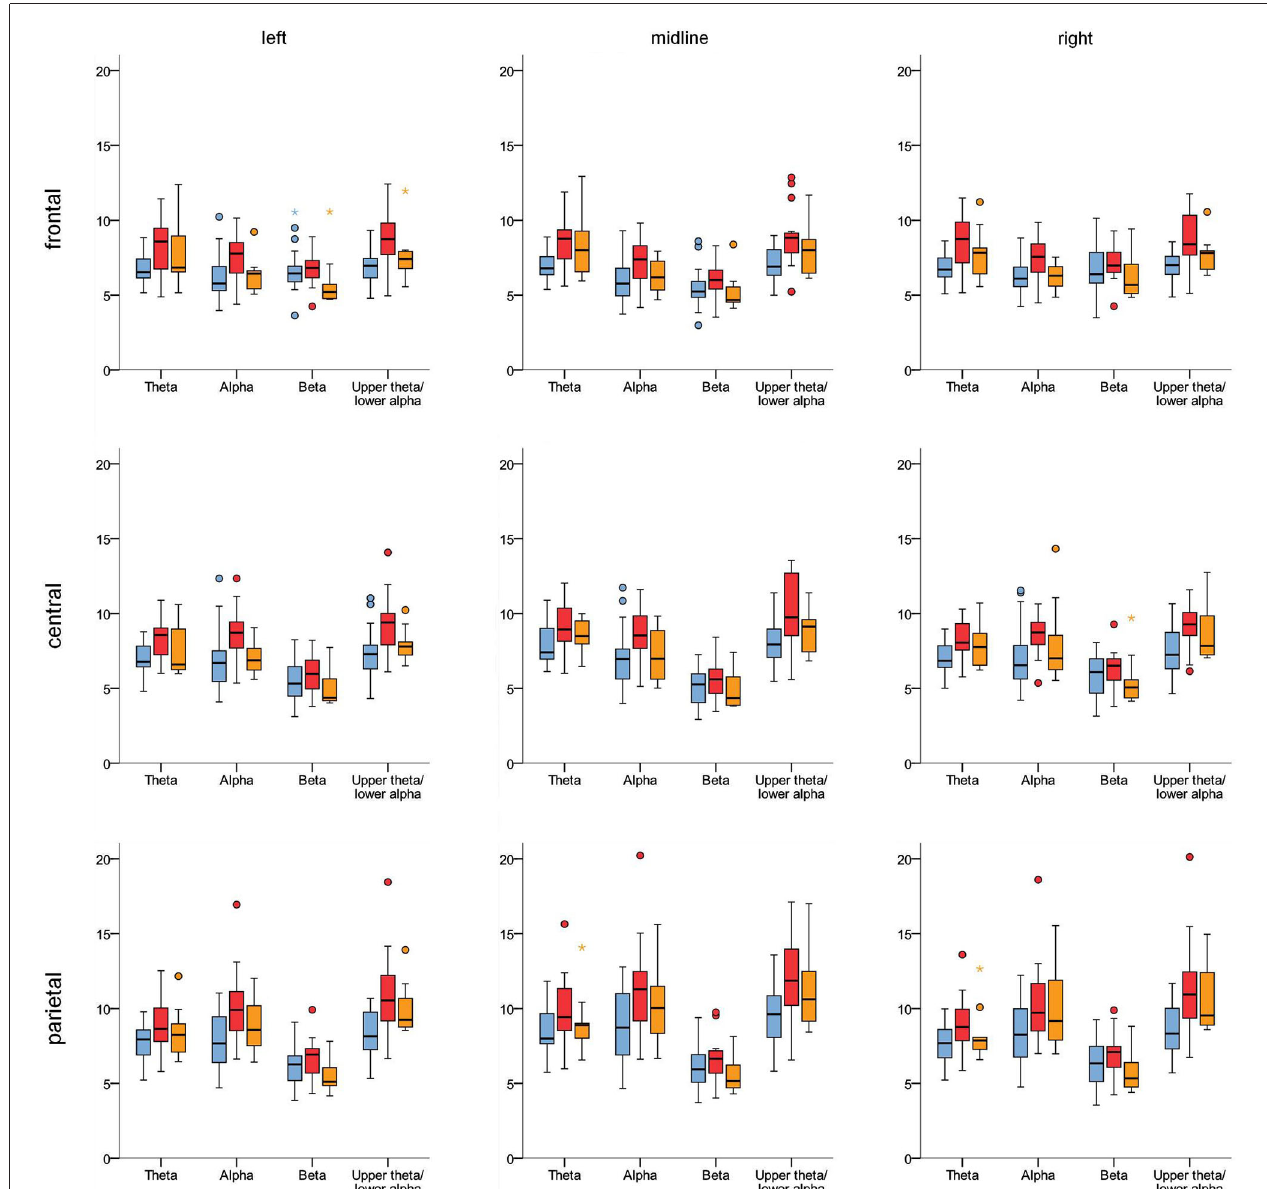
FIGURE 3 | Boxplots illustrating the topography of EEG activity in the different frequency bands for control group (blue), ADHD-C group (red) and ADHD-I group (orange) . Unit: µ V.